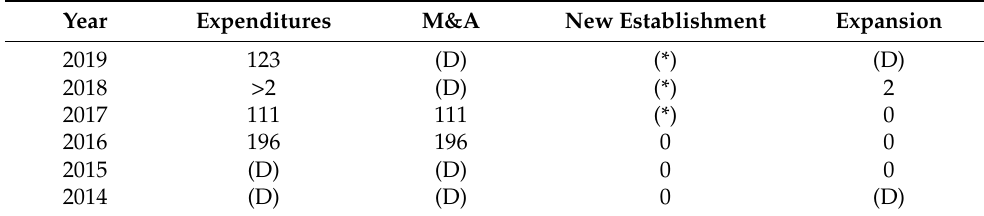
Table 1. Expenditures by New Hampshire Foreign-Owned Businesses by Type of Activity, 2014–2019 (million USD).